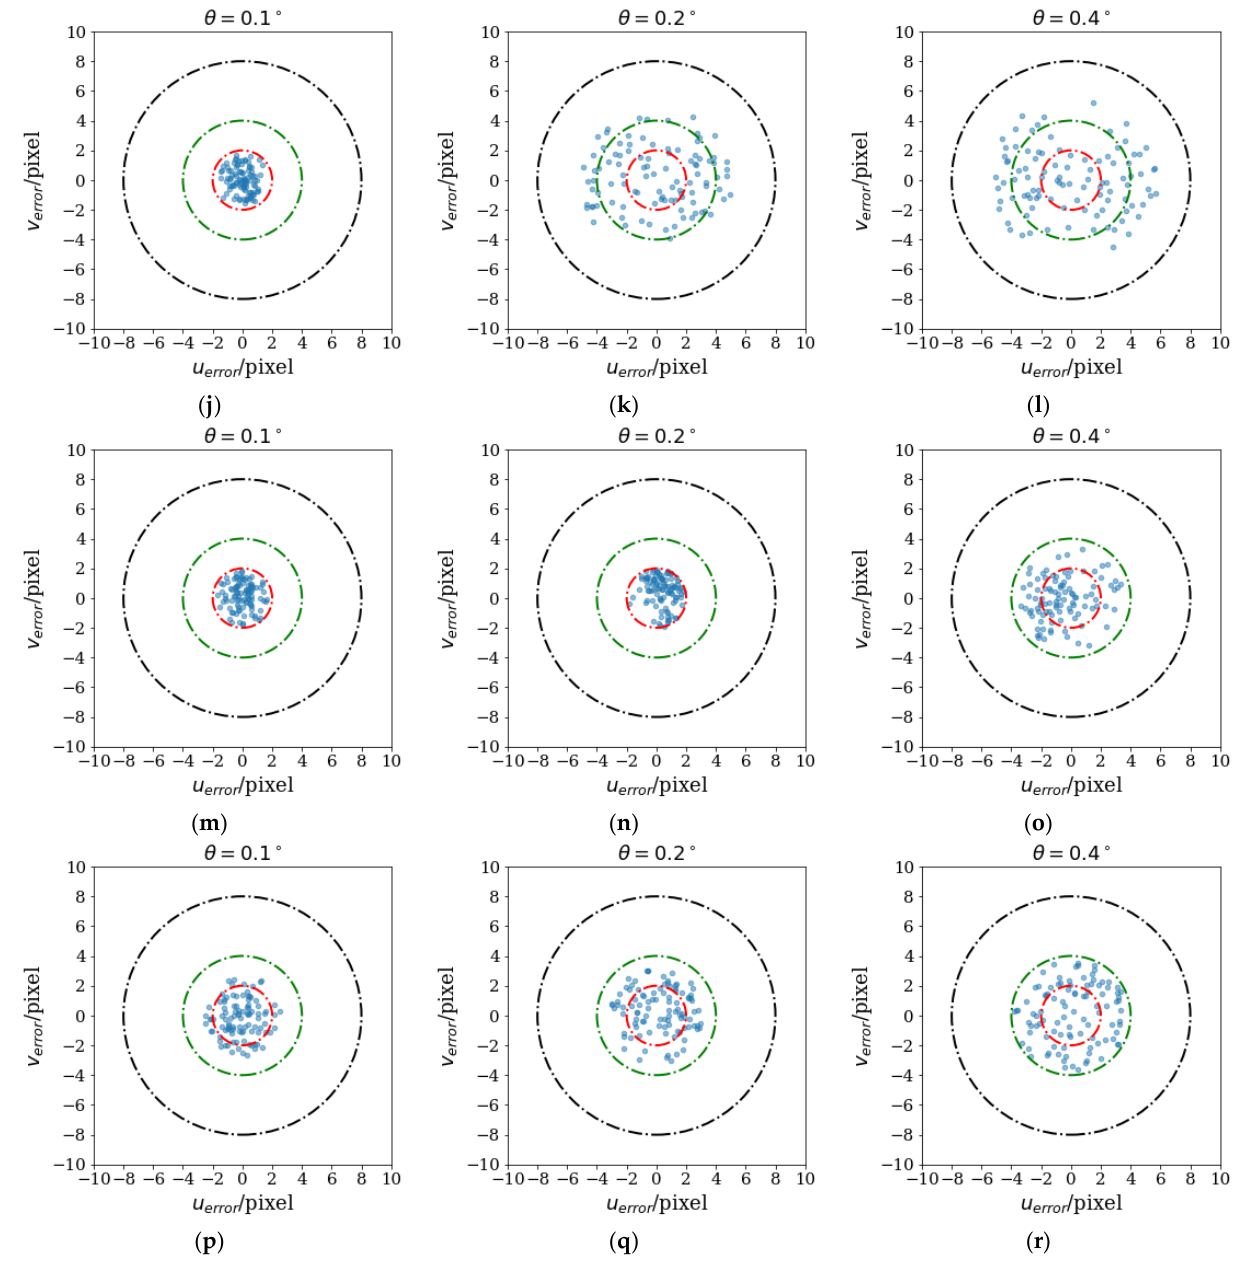
Figure 11. Error circle of different methods, the u error and v error are projection errors in the horizontal and vertical directions, respectively. ( a – c ) are proposed methods, respectively, corresponding to 𝜃 = 0.1, 0.2, and 0.4; we select one frame data for each position, ( d – f ) are methods in [18], respectively, corresponding to 𝜃 = 0.1, 0.2, and 0.4; ( g – i ) are the methods in [22], respectively, corresponding to 𝜃 = 0.1, 0.2, and 0.4, ( j – l ) are the methods in [19], respectively, corresponding to 𝜃 = 0.1, 0.2, and 0.4, ( m – o ) are the methods in [20], respectively, corresponding to 𝜃 = 0.1, 0.2, and 0.4, and ( p – r ) are the methods in [24], respectively, corresponding to 𝜃 = 0.1, 0.2, and 0.4.